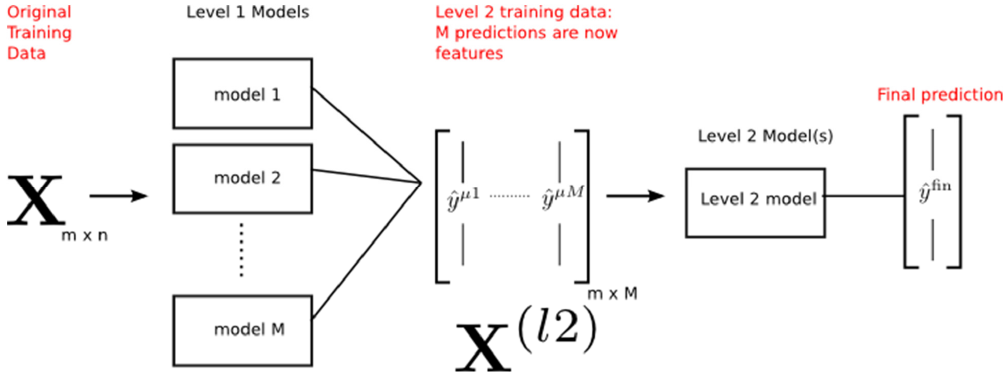
Figure 6. Functional diagram of Stacked CV Algorithm [34].